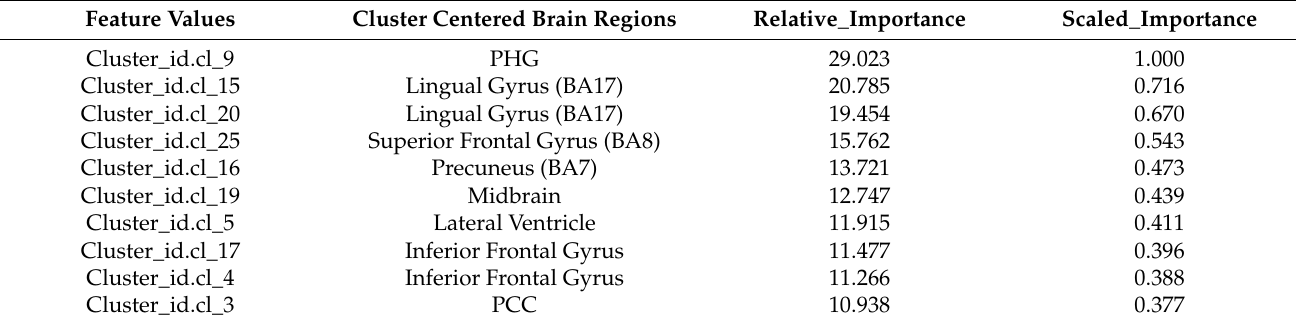
Table 7. Feature